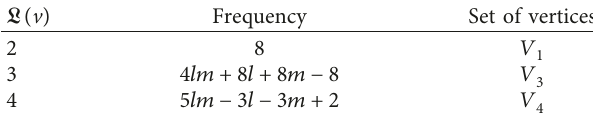
Table 1: Vertex partition of NbO.